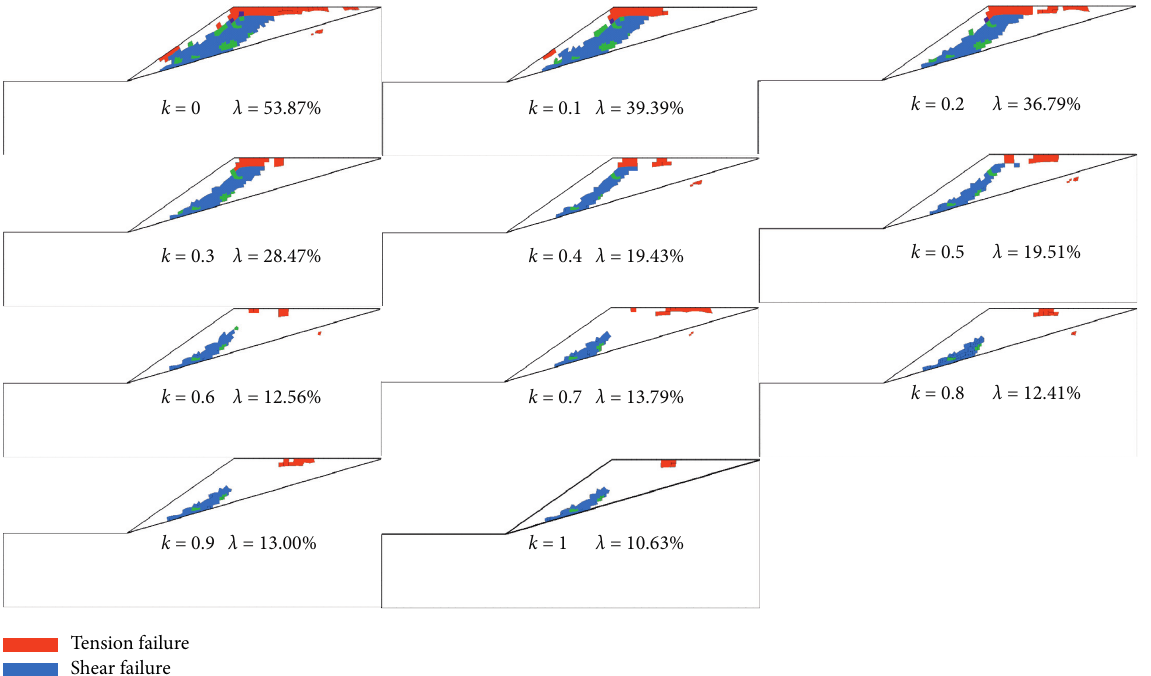
Figure 13: Failure mode.